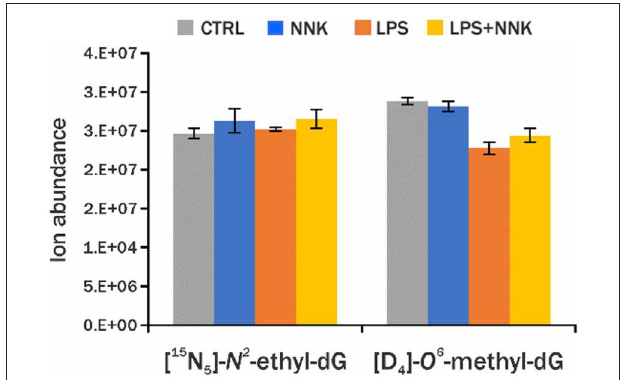
FIGURE 4 | Blue, orange, gray, and yellow histograms are levels of DNA adducts internal standards ([ 5 N 5 ]- N 2 -ethyl-dG, [D 4 ]- O 6 -methyl-dG) detected in lung sample from controls and animals treated with NNK, LPS, and LPS + NNK,